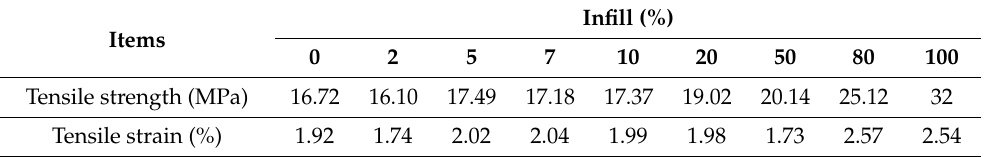
Figure 9. The tensile stress – strain curves of the PLA with the variations of infill ratio. Table 2. Mechanical properties of PLA material with a variation of infill density.